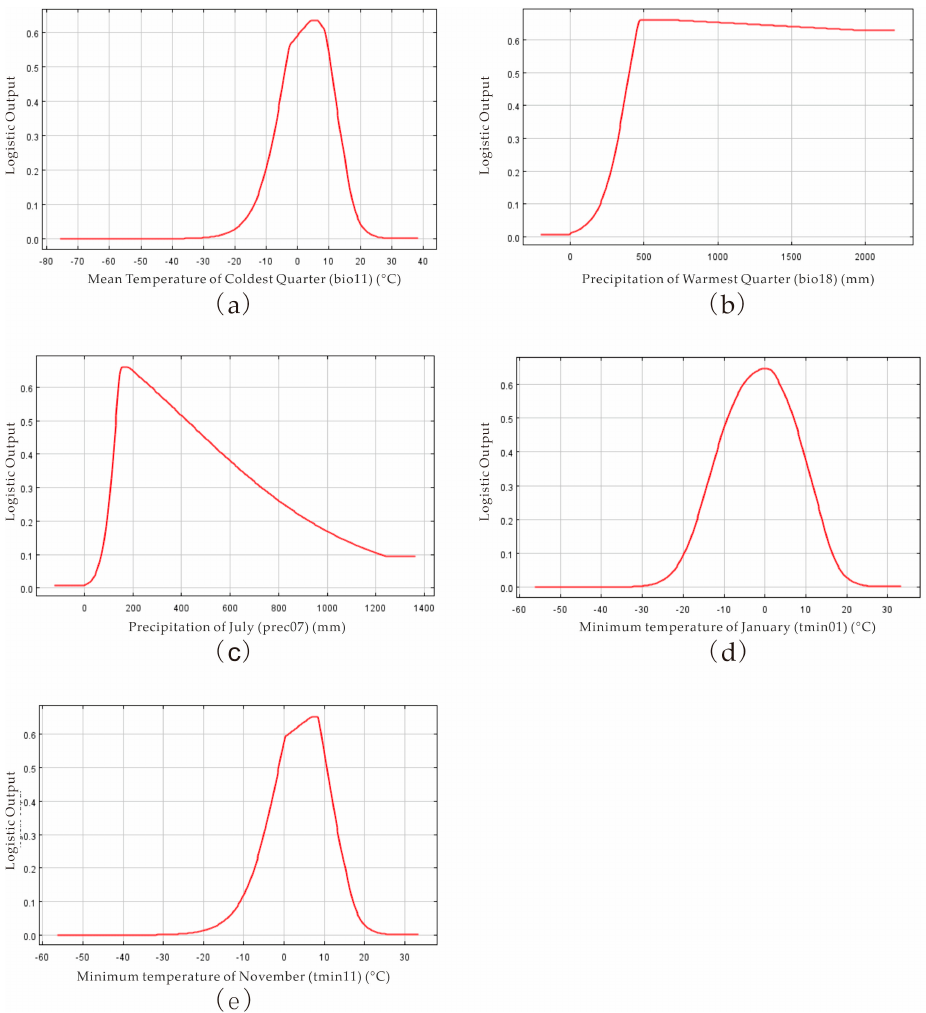
Figure 3. The importance of climate variables on the distribution of P. salicina ( a ) and M. fructicola ( b ).